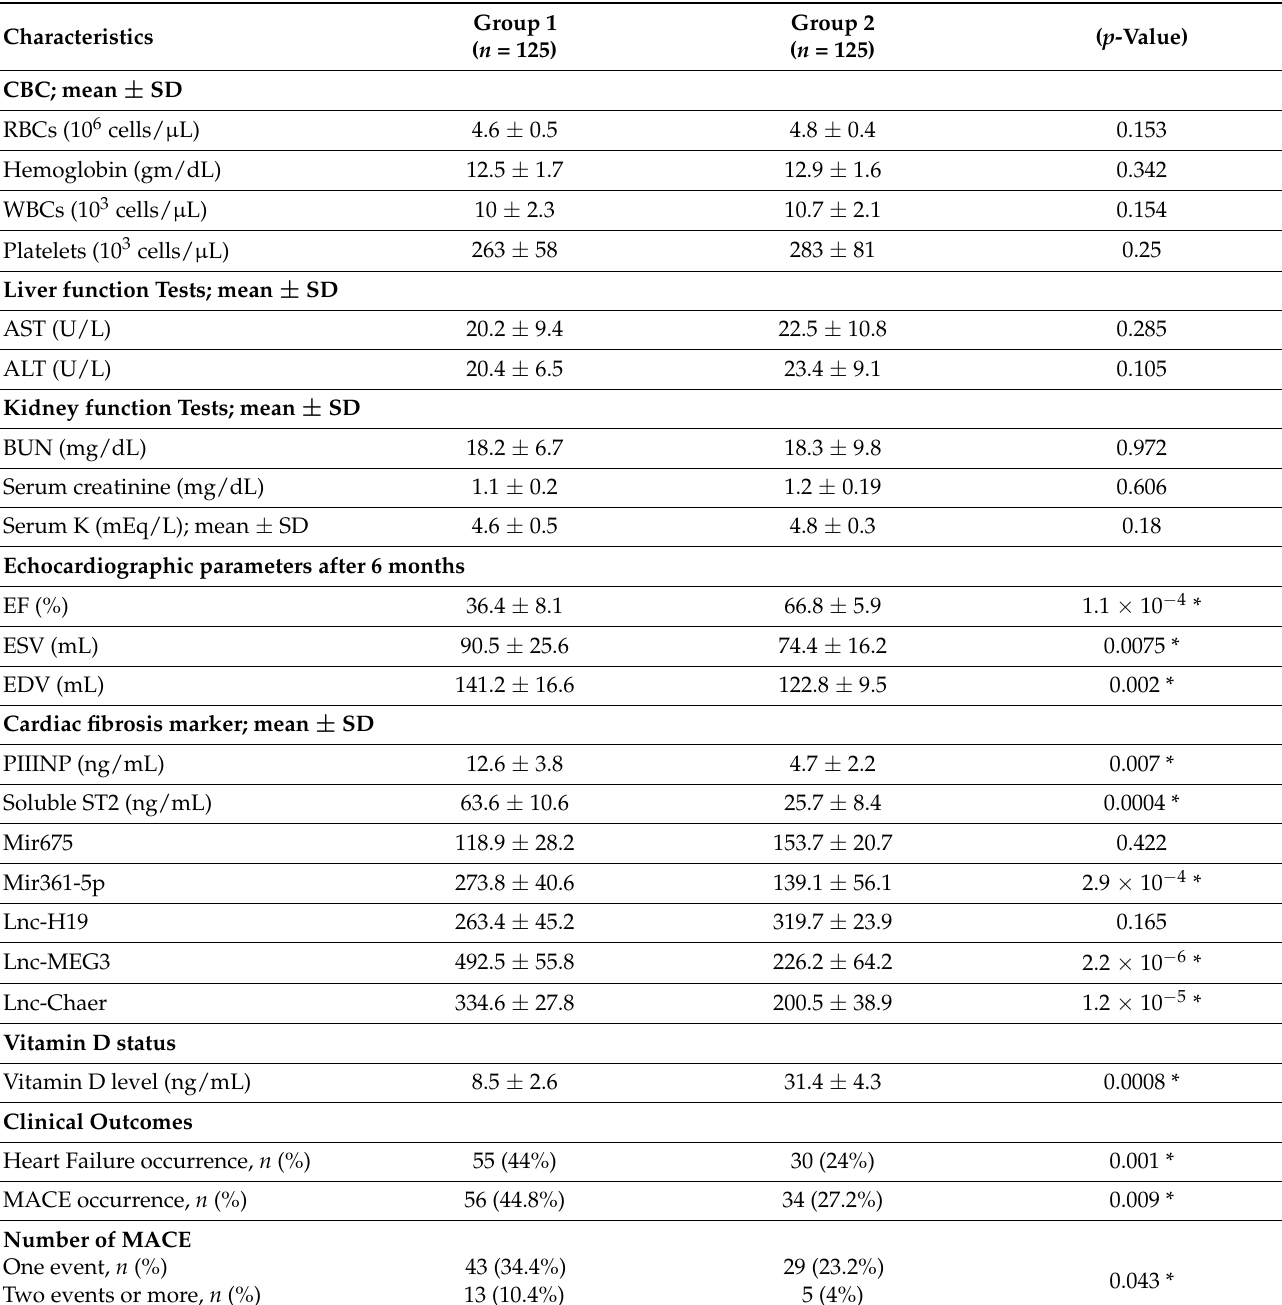
Table 2. Patients’ laboratory values and Echocardiographic parameters after 6 months of vitamin D treatment in both